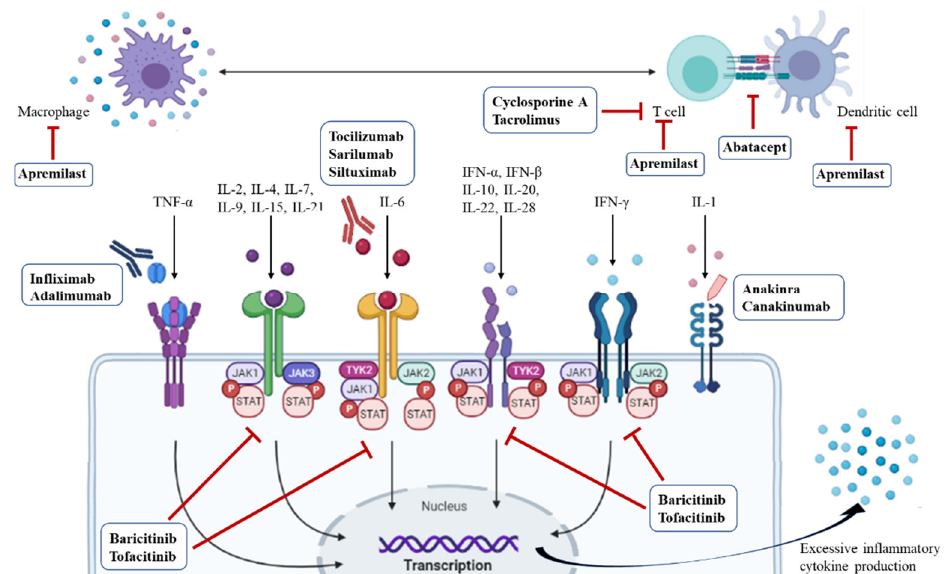
Figure 3. Schematic representation of sites of action of antirheumatic drugs. Janus kinases (JAK1, JAK2, JAK3, and TYK2) are activated by extracellular stimuli, including cytokines, and phosphorylate downstream STAT proteins, which translocate to the nucleus and activate target genes to produce inflammatory cytokines. IFN, interferon; IL, interleukin; JAK, Janus kinase; P, phosphoric acid; STAT, signal transducer and activator of transcription; TNF, tumor necrosis factor; TYK, tyrosine kinase. Table 1. Characteristics of Antirheumatic Drugs Under Evaluation for the Treatment of COVID-19.